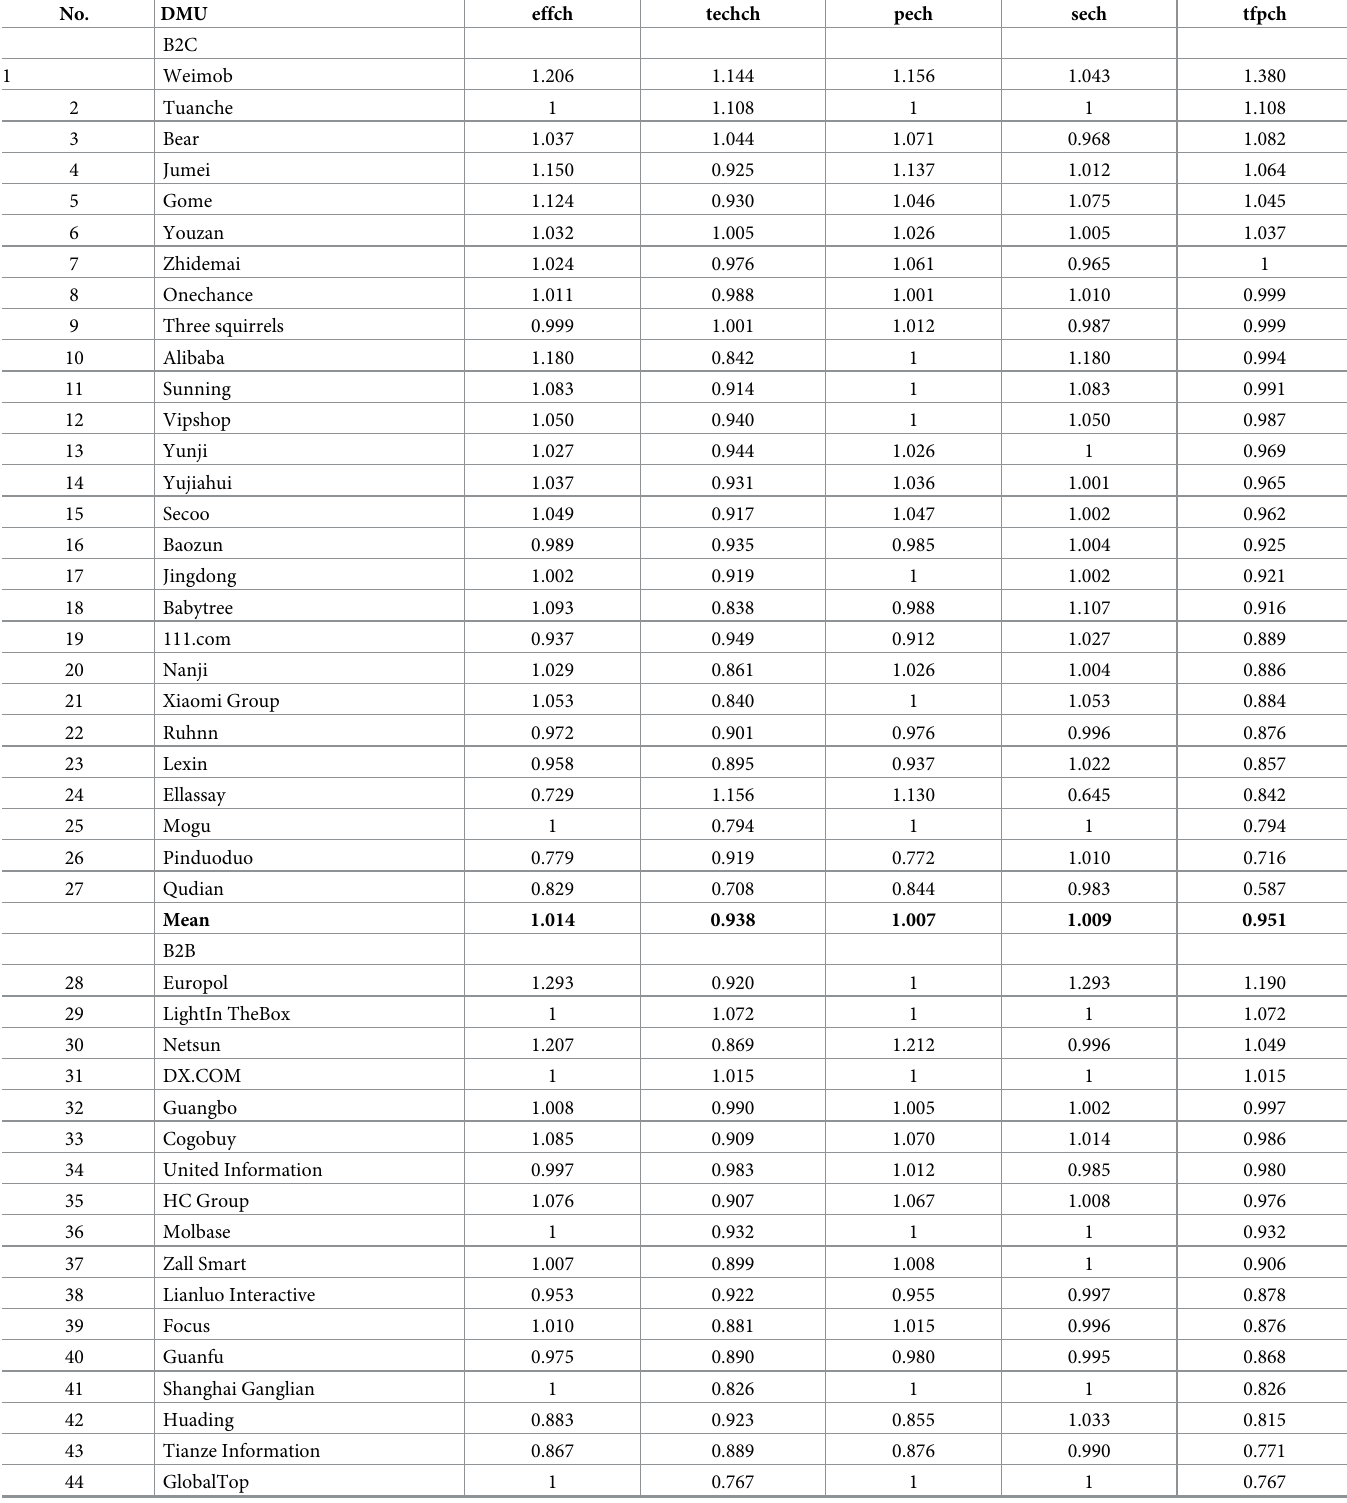
Table 6. Summary of the Malmquist total factor productivity index of different types of firms during 2015–2019 (ranked by TFPCH).